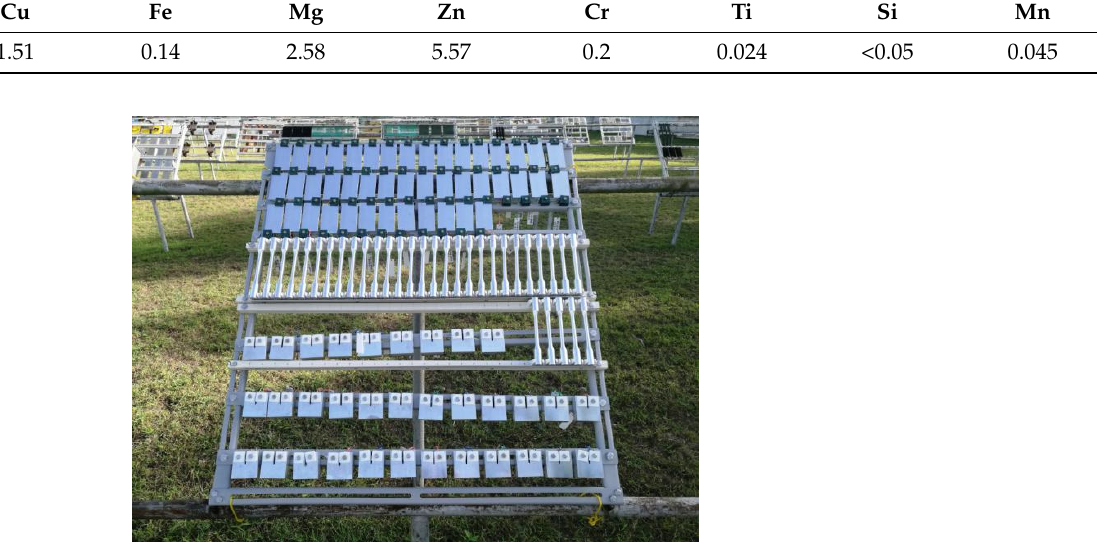
Table 1. Composition of the 7075 aluminum alloy (wt.%).